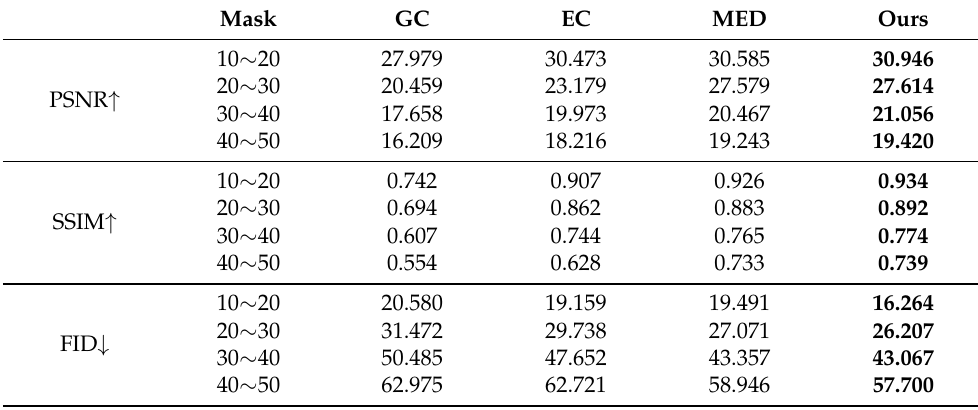
Table 2. Comparison on the CelebA